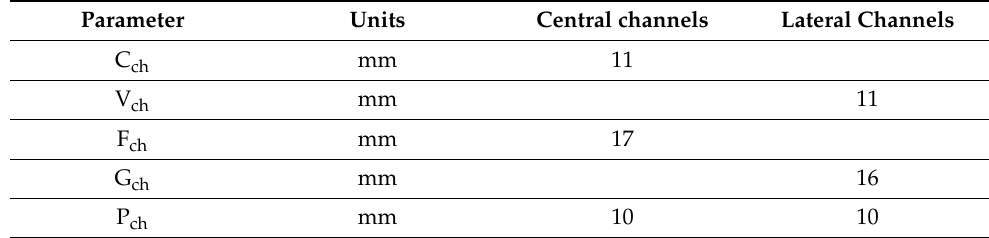
Table 4. Dimensional values of the design parameters used in the cooling of the collimating part in the mold